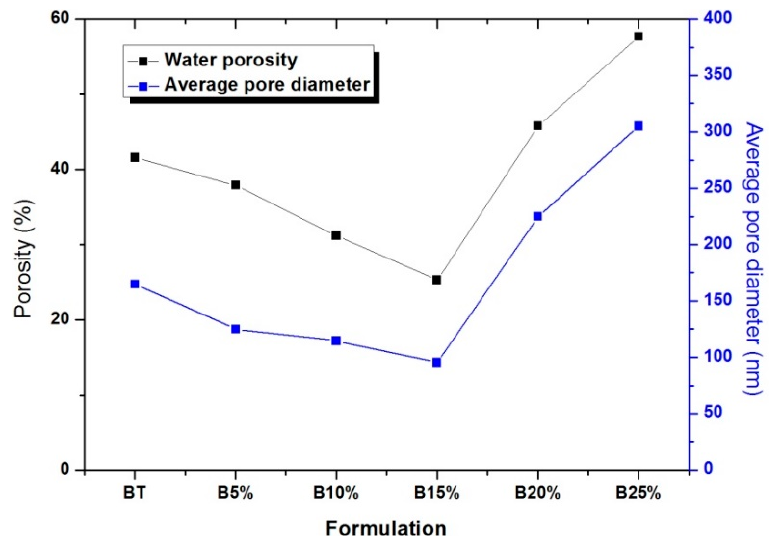
Figure 7. Evolution of water porosity and average pore diameter (obtained by BET technique) of concrete mix design studied.